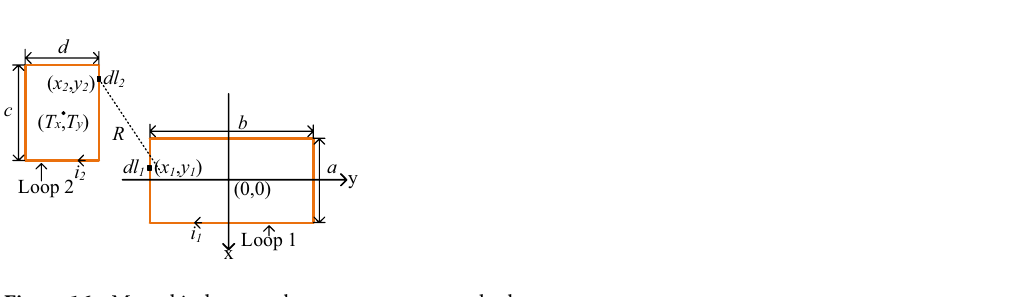
Figure 16. Mutual inductance between two rectangular